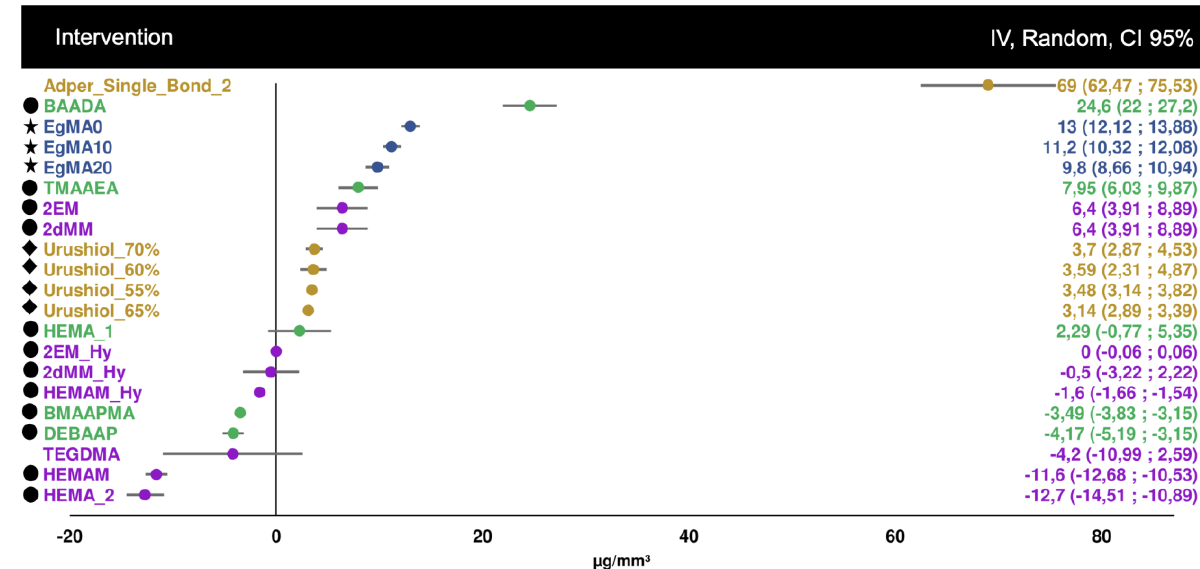
Figure 5. Forest plot that includes data of the water solubility measured in 4 individual studies. Symbol legend: ★ eugenyl methacrylate derivatives; ● methacrylamide derivatives.